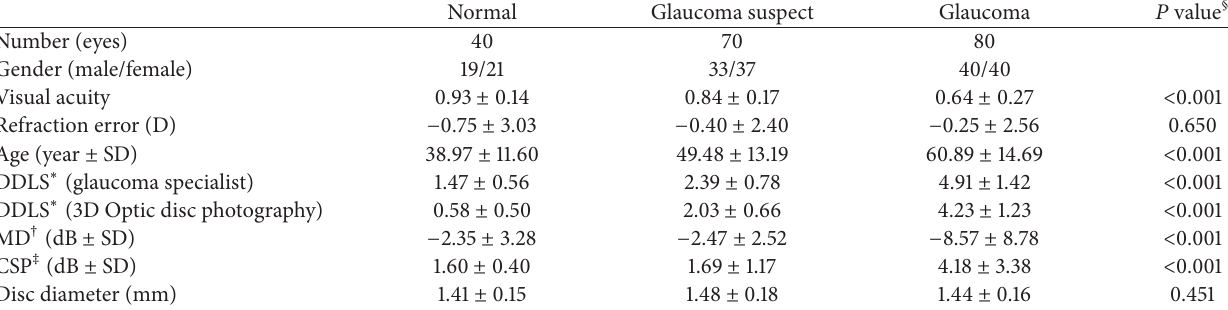
Table 1: Patient demographics and baseline characteristics ( 𝑛 = 190